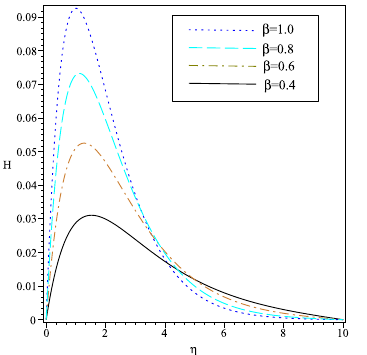
Fig. 2: The profile micro-rotation H ( η ) obtained by the direct RBFs for different values of β at ϕ = 0 and ε = 0.1 .